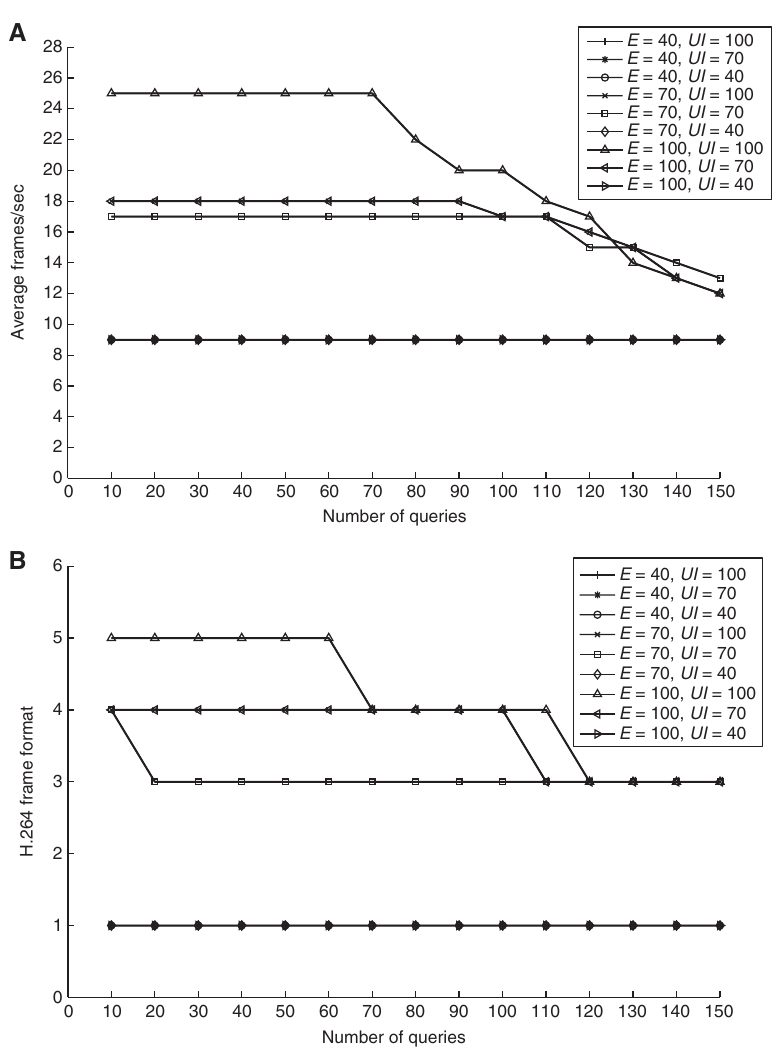
Figure 7: Average Frames/Second and H.264 Frame Format when both Energy and User Input are Fixed. (A) Video stream quality in fps. (B) Video stream quality in H.264 frame